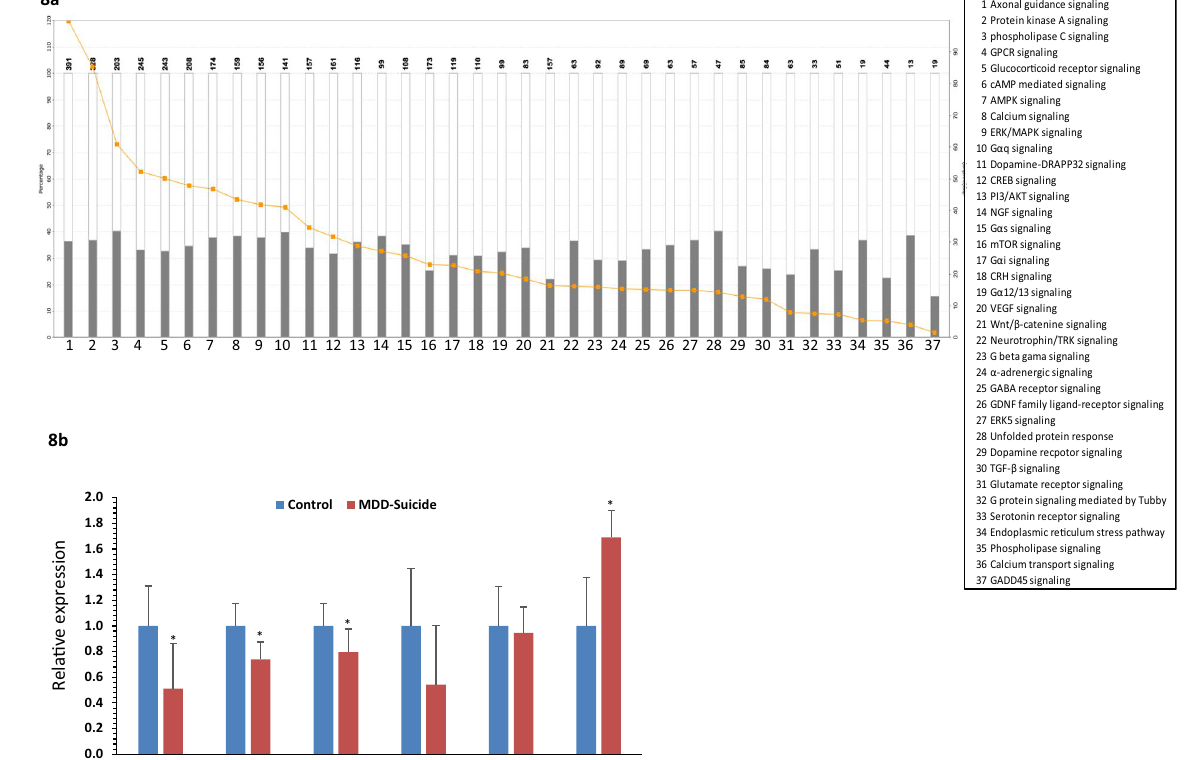
Figure 8. Relating functional disorders with dysregulated miRNAs based on predicted target genes and their validation. ( a ) Affected canonical pathways mediated by deregulated miRNA network. Canonical biological pathways associated with genes that were predicted to be targets of significantly altered miRNAs in MDD- suicide subjects are shown (p < 0.05, Fisher’s Exact Test). The ratio is calculated as the number of genes in a given pathway divided by the number of genes that make up the pathway. The p-value for a given process annotation is calculated by considering the number of focus genes that participate in that process and the total number of genes that are known to be associated with that process in the selected reference set. The more focus genes involved, the more likely the association is not due to a random chance. ( b ) Expression status of few selected genes identified as targets of altered miRNAs. Transcript levels of RELN, GSK-3 β , MAOA, CHRM1, PLCB1 and GRIK1 were analyzed in locus coeruleus of MDD-suicide and healthy control subjects by qPCR using primers mentioned in the Methods section. GAPDH normalized relative expression level of RELN, GSK-3 β , MAOA, CHRM1, PLCB1 and GRIK1 mRNA transcripts were analyzed in locus coeruleus of MDD-suicide as compared with the normal healthy control group. All data are the mean ± SEM (for RELN, GSK-3 β and GRIK1, n = 10 in control and n = 9 in MDD-suicide group; for MAOA, n = 9/group). The level of significance was determined using independent-sample ‘t’ test. ‘ * ’ denotes significant difference between MDD- suicide and control groups (RELN p = 0.038; GSK-3 β p = 0.009; MAOA p = 0.032; GRIK1 p =